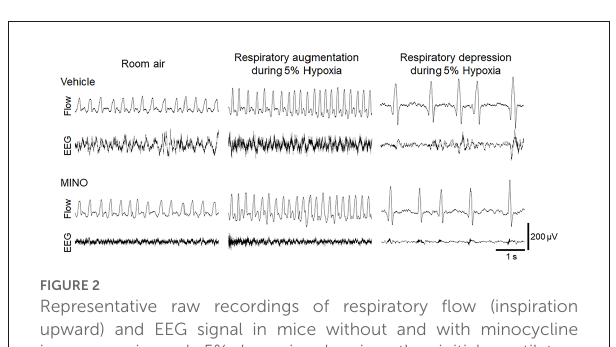
FIGURE2 Representative raw recordings of respiratory flow (inspiration upward) and EEG signal in mice without and with minocycline in room air and 5% hypoxia showing the initial ventilatory augmentation and late ventilatory fall-off. Minocycline failed to influence the hypoxic ventilatory